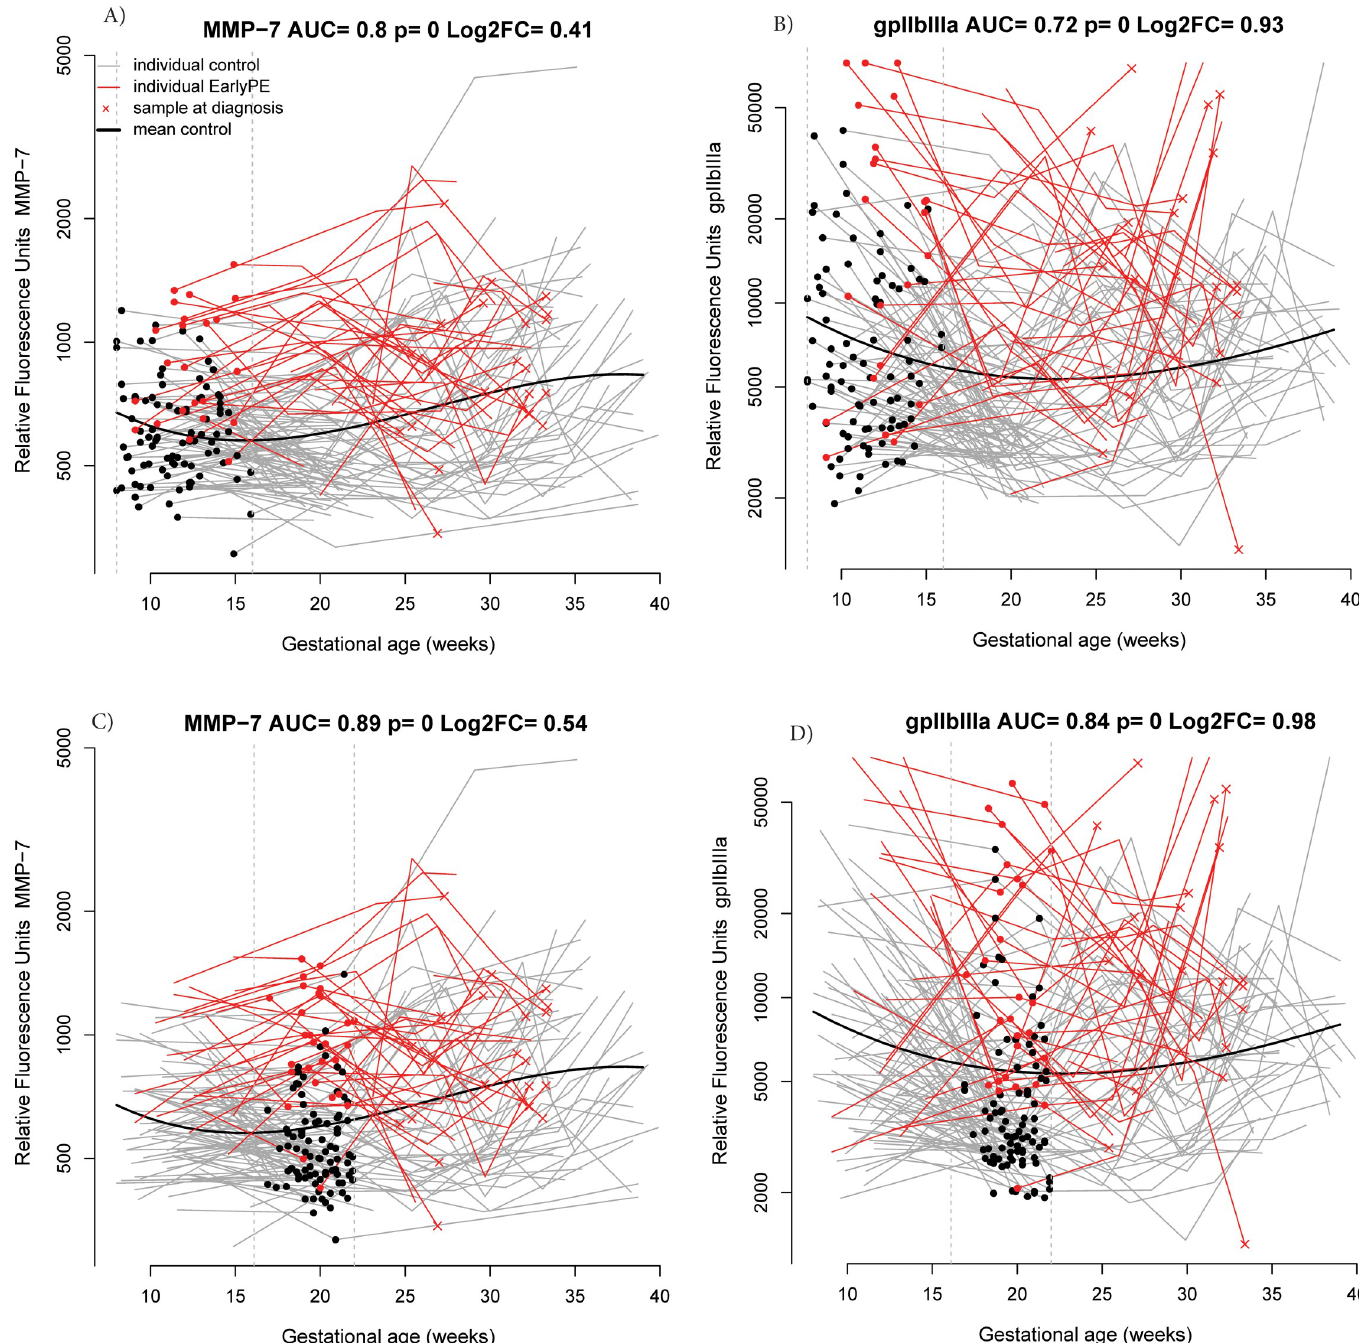
Fig 2. Longitudinal maternal plasma abundance of MMP-7 and gpIIbIIIA in normal pregnancy and early preeclampsia. Each line corresponds to a single patient (grey = normal pregnancy, red = early preeclampsia). Individual dots represent samples at 8–16 weeks ( A, B ) and 16.1–22 weeks ( C, D ) of gestation. Samples taken at the time of diagnosis with early preeclampsia are marked with an “x” and were not included in the analysis but only displayed. The thick black line represents the mean value in normal pregnancy. AUC: area under the receiver operating characteristic curve of the protein using data in the current interval; early PE: early preeclampsia; FC: fold change; gpIIbIIIa: glycoprotein IIb/IIIa; MMP-7: matrix metalloproteinase 7; MoM: multiples of the mean; p: the nominal significance p-value comparing mean MoM values between groups with a moderated t-test. Log 2 FC is the log (base 2) of the fold change between the cases and control groups, with negative values denoting lower MoM values in cases than in